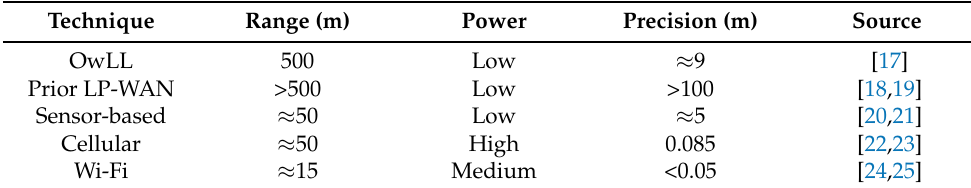
Table 3. Comparison of different techniques for